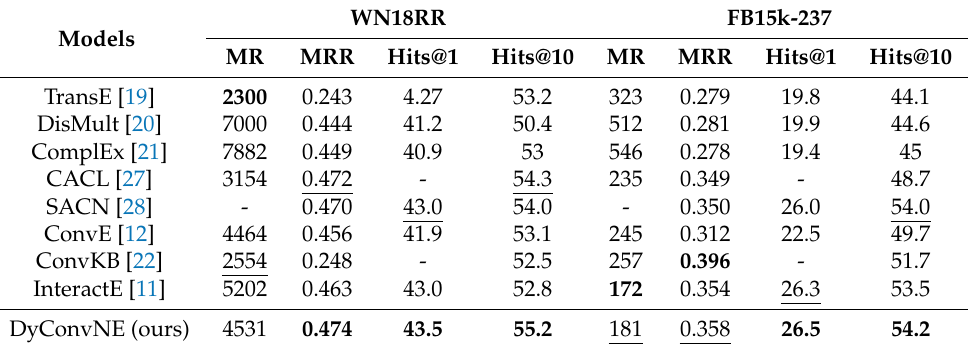
Table 6. Experimental results on WN18RR and FB15K-237 test sets. Results are taken from the corresponding papers. Hits@N values are in percentage. The best score is in bold and second best score is